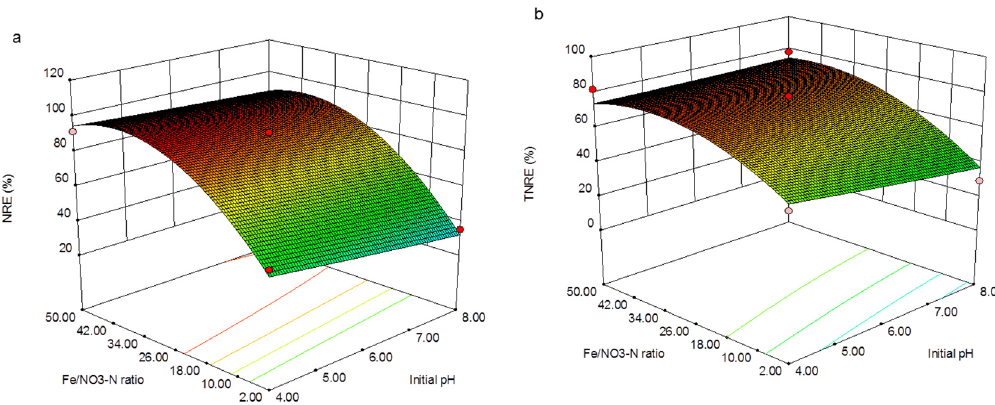
Figure 4. Response 3D-surface plot of ( a ) NRE and ( b ) TNRE at different Fe/NO 3 -N ratio versus initial pH.